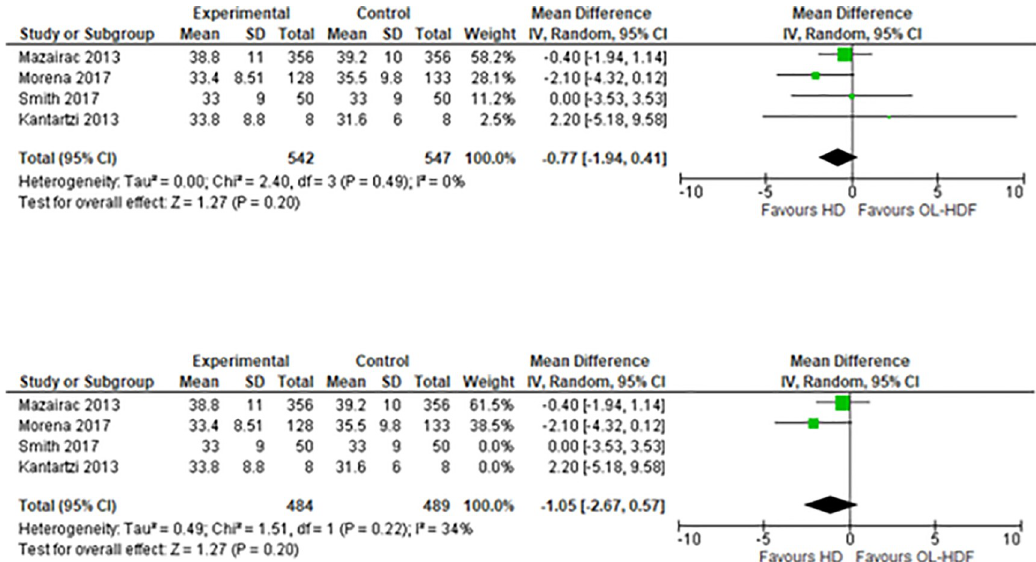
Fig 3. Fig 3–1 Meta-analysis of PCS, Fig 3–2 Sensitivity analysis of